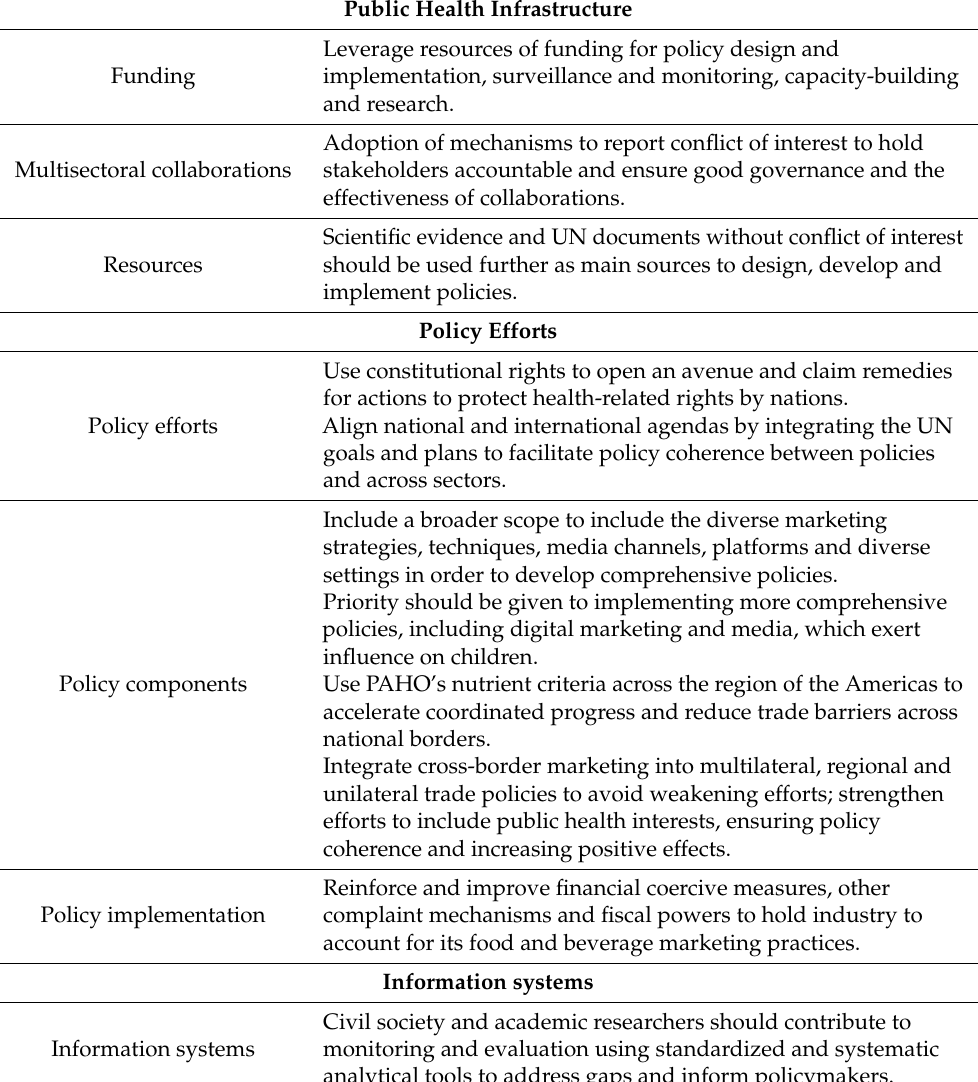
Table 5. Priorities for further action to increase government capacity-building to restrict the marketing of HFSS foods and non-alcoholic beverages to children in the region of the